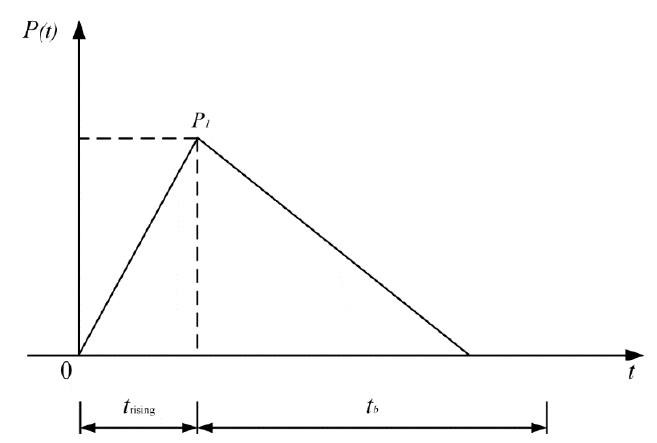
Figure 7. Curve of blasting load.